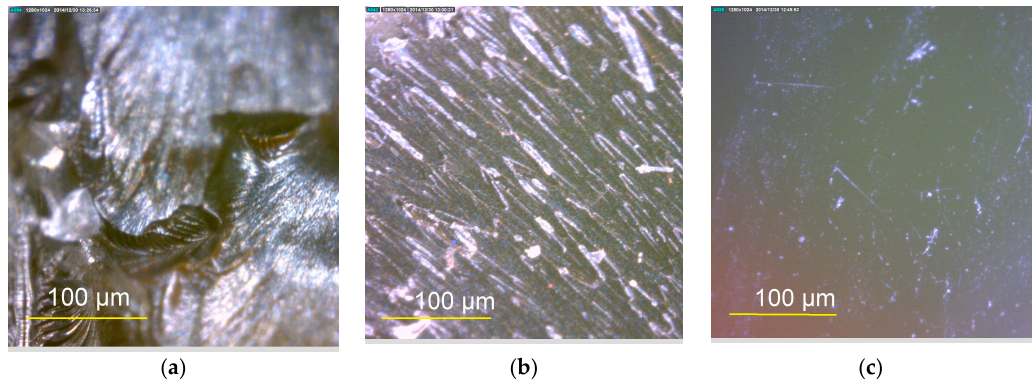
Figure 9. Failure surfaces of PU samples of tensile test. ( a ) PU0; ( b ) PU6; ( c ) PU15.